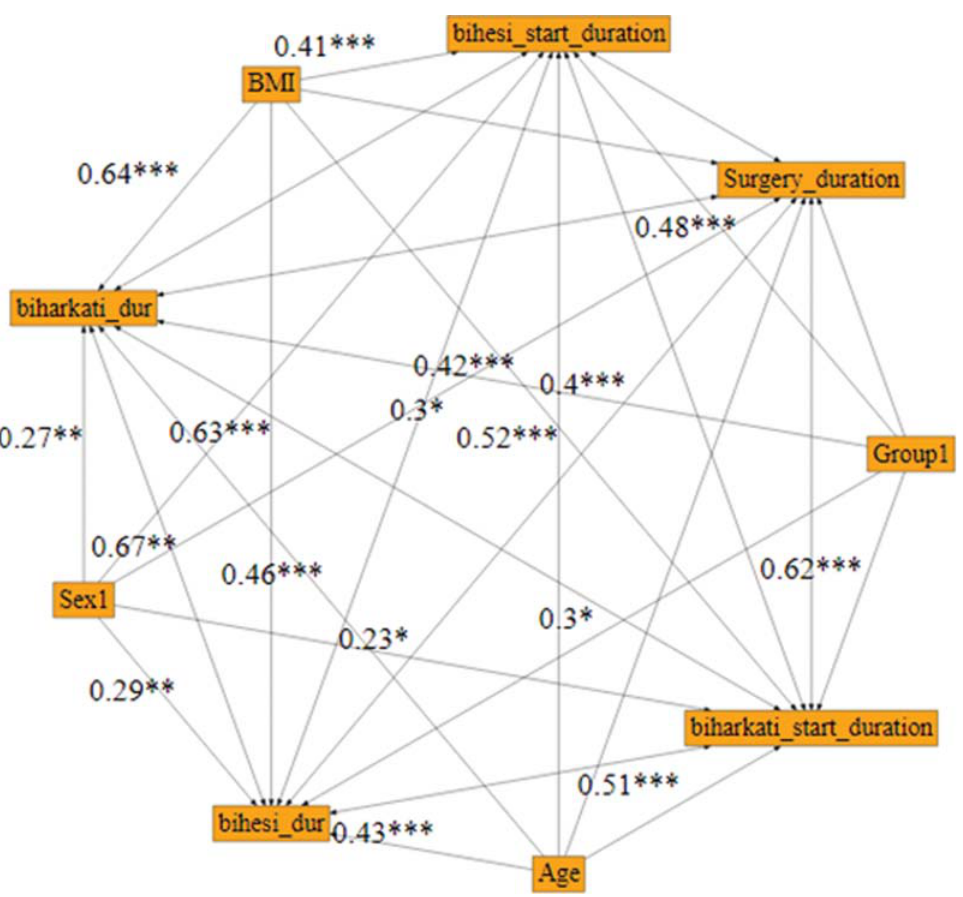
Fig. 1 Investigation of the effect of intervention on the dependent variables in the subgroup of biological agents at different times using Bayesian path